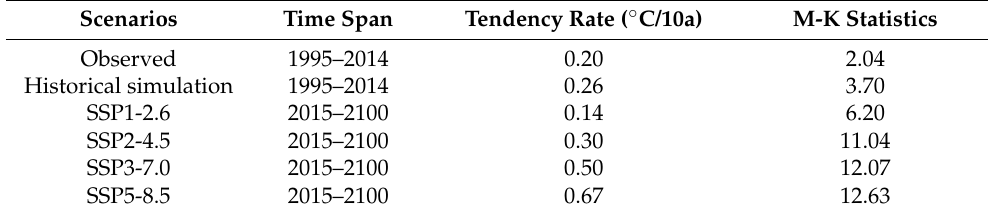
Table 4. Tendency rate and M ‐ K statistics of extreme rainfall index under SSPs scenarios in the Huai Table 3. The tested results of temperature variation trend under different scenario for the Huai River River basin.